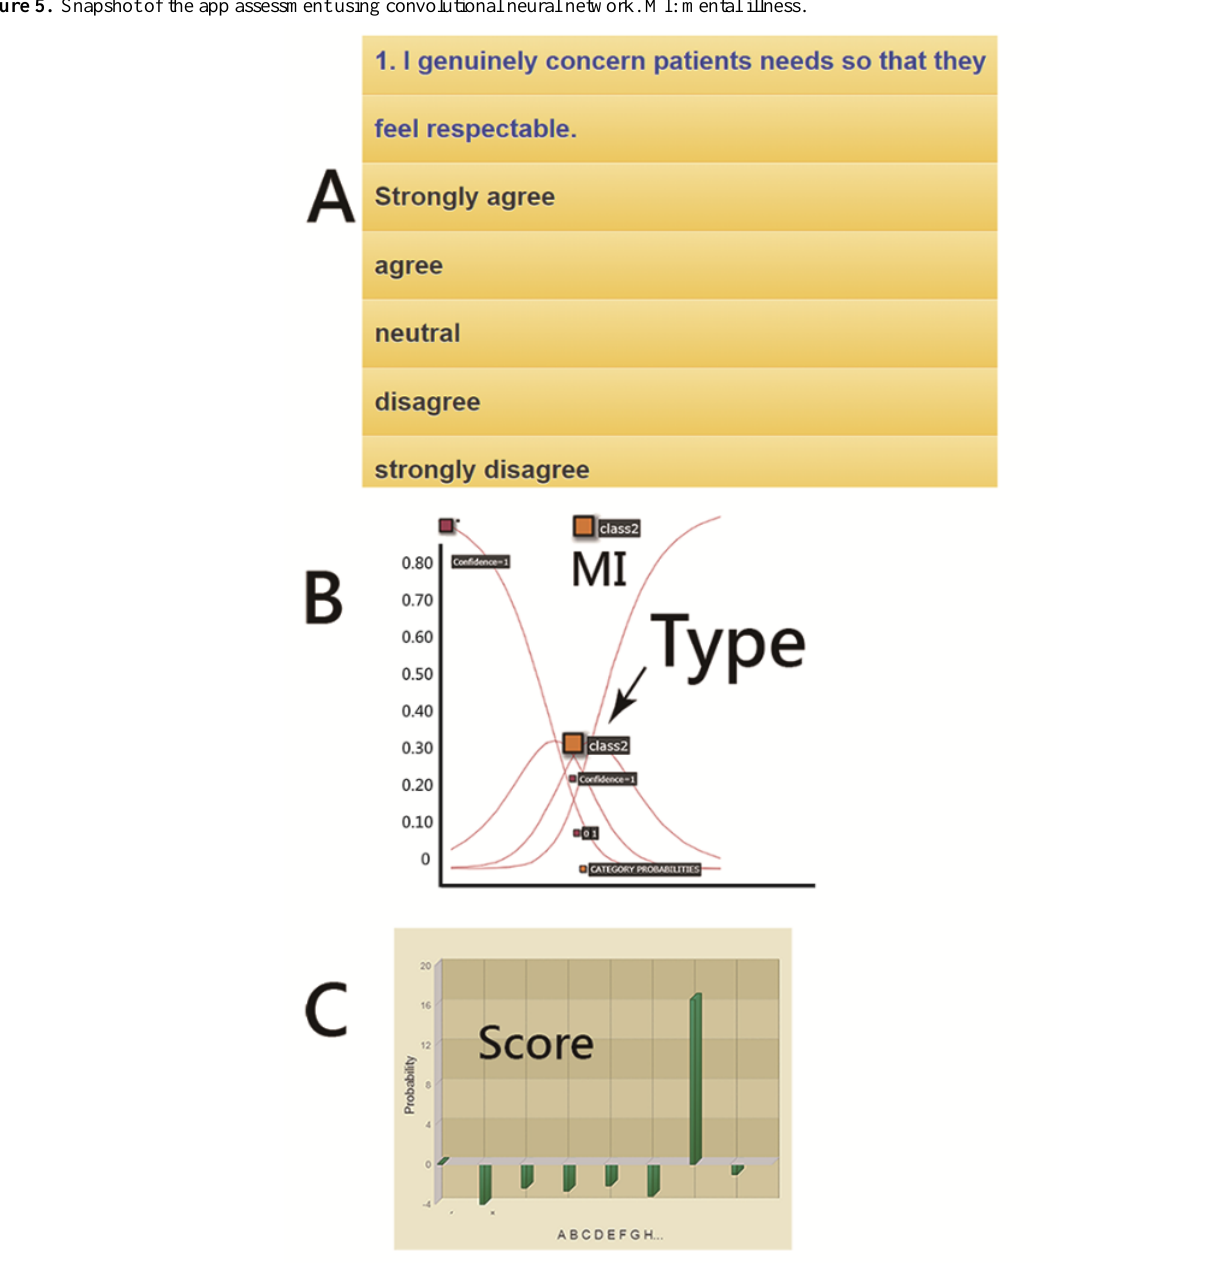
Figure 5. Snapshot of the app assessment using convolutional neural network. MI: mental